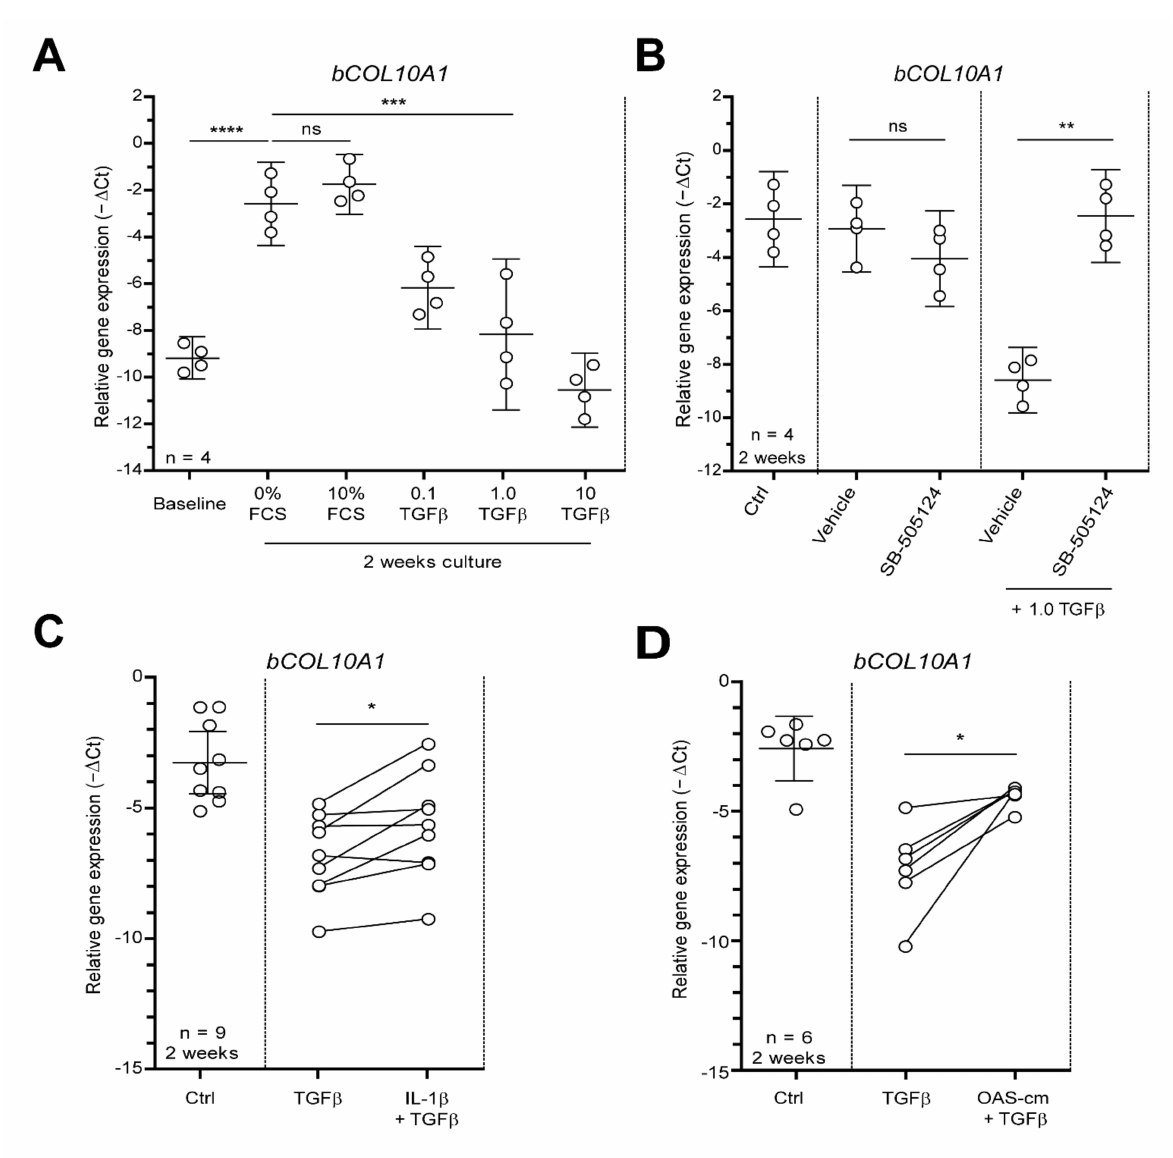
Figure 1. OA-related inflammation blocks anti-hypertrophic function of TGF- β in bovine cartilage explants. To induce hypertrophy-like differentiation, bovine cartilage tissue explants were cultured ex vivo for 2 weeks and medium was replaced every 3rd day. ( A ) Culturing cartilage explants for 2 weeks with or without FCS spontaneously induced hypertrophy-like differentiation, as measured by relative collagen type 10 ( COL10A1 ) mRNA expression using qPCR. To study the anti- hypertrophic role of TGF- β , the effect of different concentrations of rhTGF- β 1 (0.1, 1 and 10 ng/mL) on COL10A1 mRNA expression was measured (in medium without FCS). ( B ) Co-incubation with 5 µ M ALK-5 kinase activity inhibitor SB-505124 fully blocked TGF- β (1 ng/mL) effects on COL10A1 mRNA expression compared with vehicle (DMSO). ( C , D ) To study the interaction between TGF- β and inflammatory mediators in this model of hypertrophy, explants were exposed to 0.1 ng/mL TGF- β with 1 h pre-incubation of 0.1 ng/mL IL-1 β ( C ) or 0.5% OAS-cm ( D ). Data are plotted as mean ± 95% CI with each dot representing the average of 2 replicates of 4 explants in one cow. Statistical analysis was performed using a repeated measures one-way analysis of variance with Bonferroni’s post hoc test (A + B) or a two-tailed Student’s paired t -test (C + D): ns non-significant p > 0.05; * p ≤ 0.05; ** p ≤ 0.01; *** p ≤ 0.001; **** p <